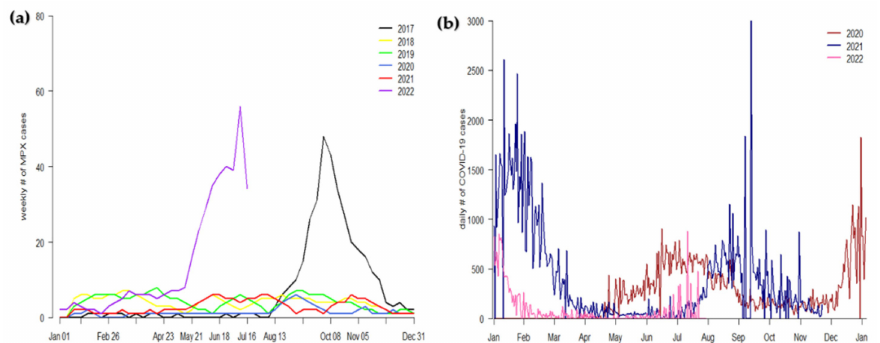
Figure 1. Panel ( a ): time-series simulation results of the monkeypox virus in Nigeria from 2017 to 2022. Panel ( b ): time series simulations result of the COVID-19 epidemic situation in Nigeria from 2020 to 2022. The cases data were obtained from [4,20].